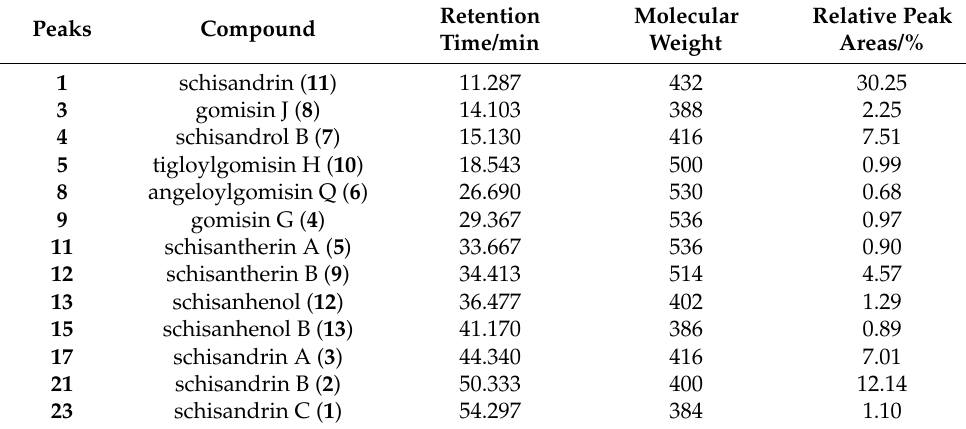
Figure 5. The HPLC chromatogram of mixed reference substances. Table 5. The identified common peaks of characteristic chromatogram.